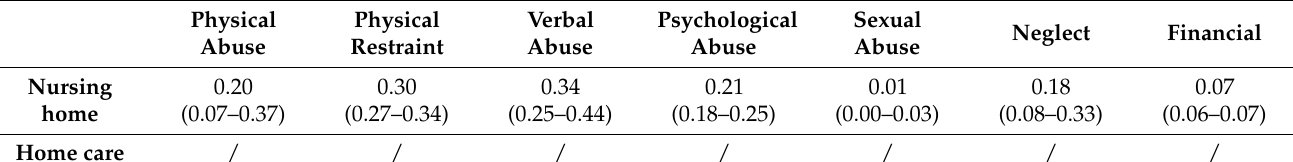
Table 3. HCWs witnessed violence in different LTC settings.